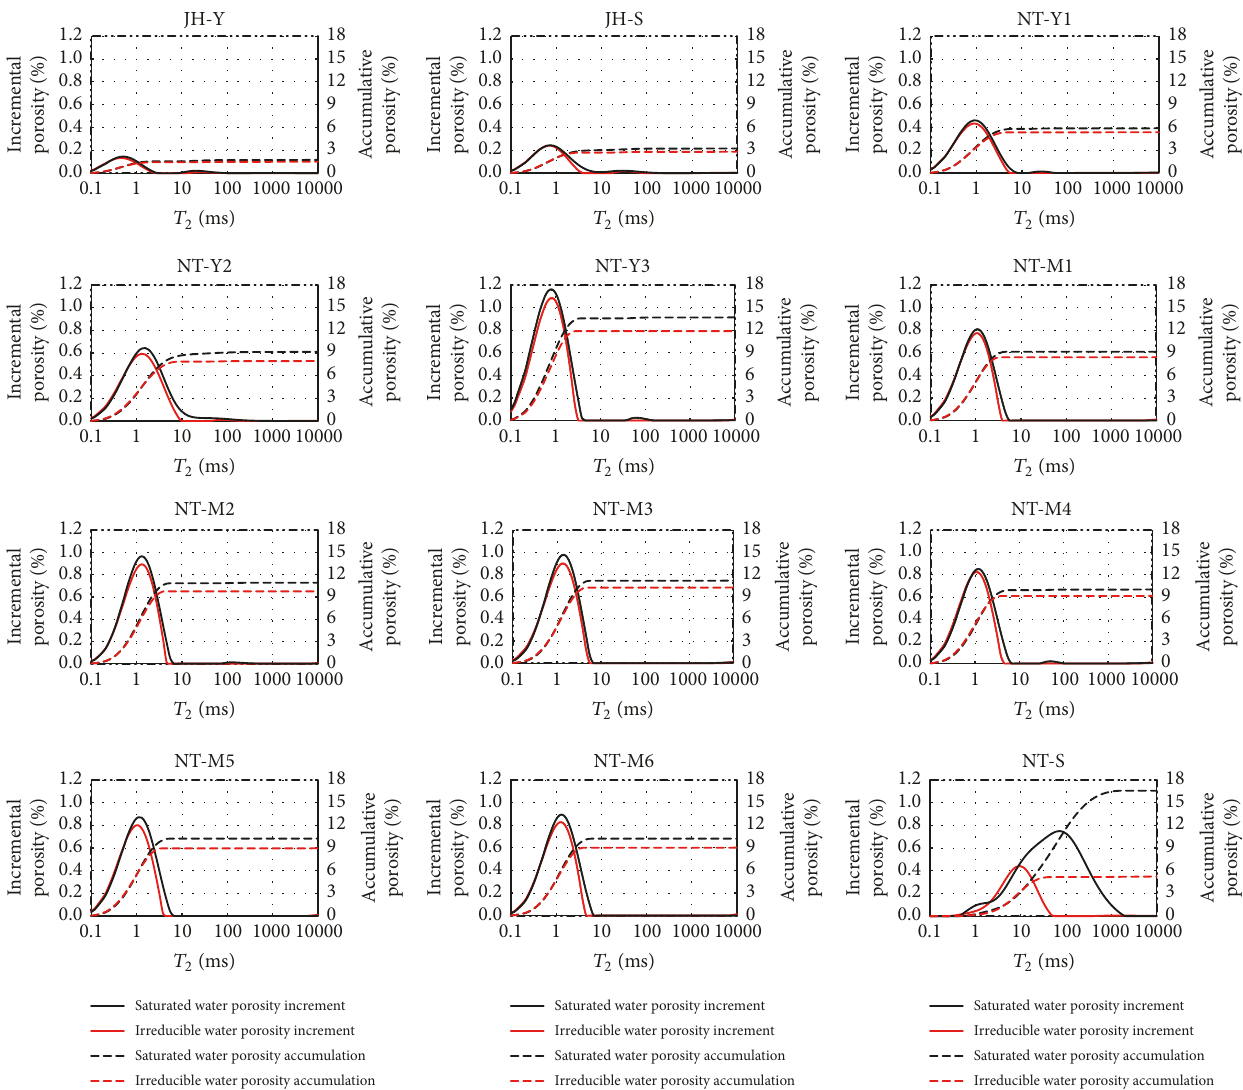
Figure 11: 𝑇 2 spectra of the NMR measurements under the full water-saturated ( 𝑆 𝑤 ) condition (black line) and irreducible-water-saturated ( 𝑆 ) condition (red ir